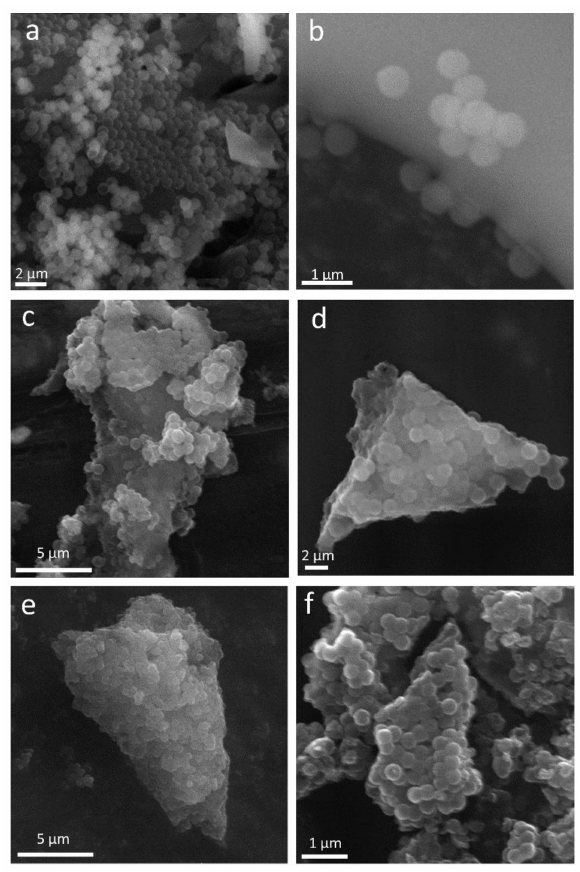
Figure 2. SEM images of silica template ( a , b ) and carbon spheres after 1 h ( c ), 2 h ( d ), 3 h ( e ), and 4 h ( f ) of